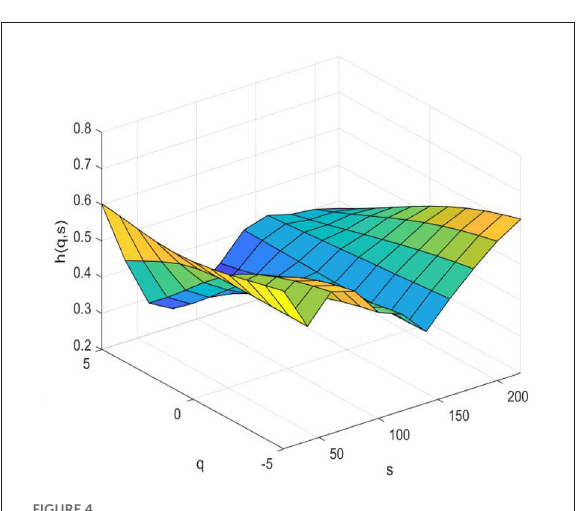
FIGURE4 Risk spillover of the system